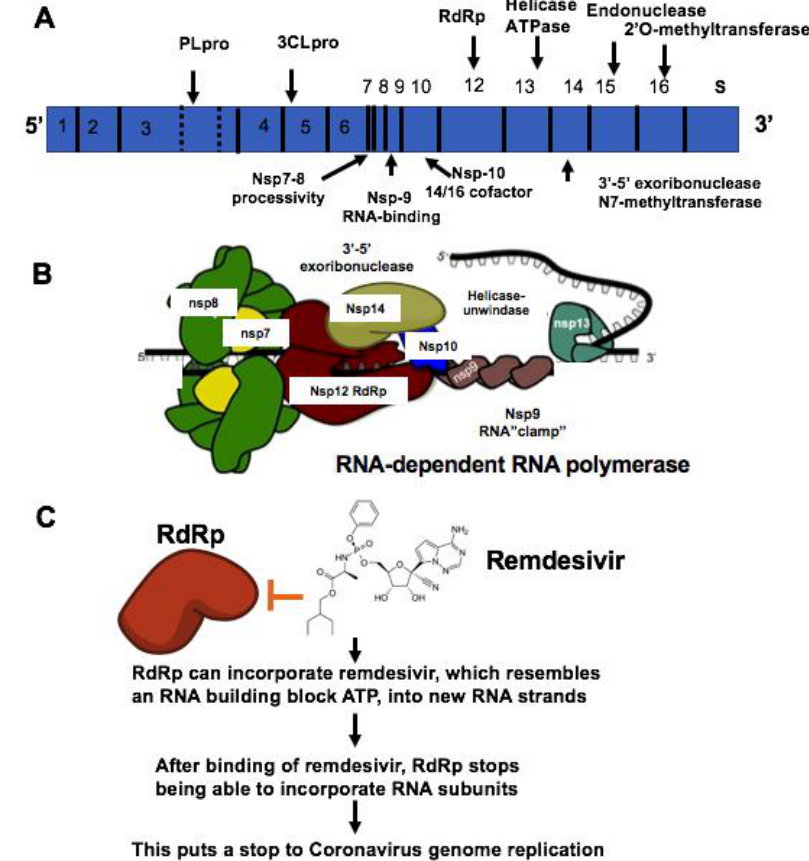
Figure 1. Mechanisms of remdesivir to inhibit RNA-dependent RNA polymerase (RdRp). ( A ) The genome composition model of single strand RNA (ssRNA) of coronavirus. ( B ) The RNA-dependent RNA polymerase RdRp mediated RNA replication during coronavirus infection. ( C ) Remdesivir functions as the ATP analog to inhibit RdRp.